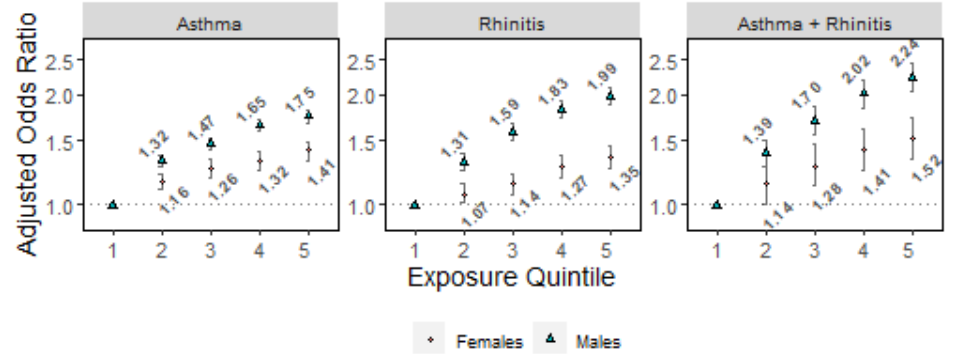
Figure 4. Odds radios and 95% confidence intervals of effect modification by sex for the association between NOx and asthma, allergic rhinitis and their co-morbidity, adjusted for year of birth, census SES, and school religious orientation. Females: n = 945,942, cases: asthma-47,962, allergic rhinitis-38,274, co-occurrence (asthma and allergic rhinitis)-12,101. Males: n = 1,365,298, cases: asthma-92,204, allergic rhinitis-71,533, co-occurrence (asthma and allergic rhinitis)-25,210. 1 = lowest NOx exposure category (< 5.63 ppb), 2 = (5.63–10.5 ppb), 3 = (10.5–14.7 ppb), 4 = (14.7–19.1 ppb) and 5 = (19.1–130 ppb).